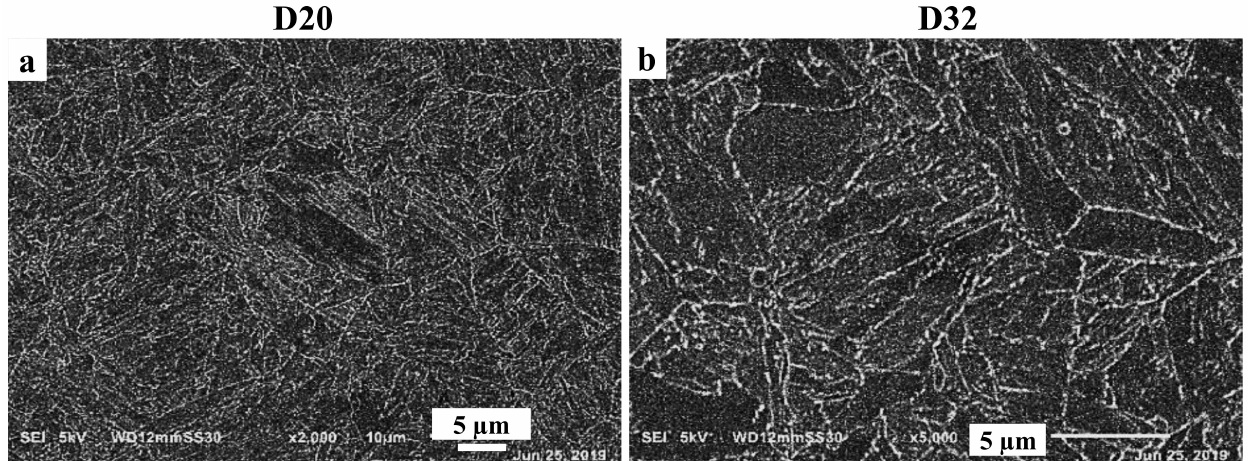
Figure 3. SEM micrographs of B500B steel grade. ( a , b ) show the tempered martensite surface layer for both D20 and D32,